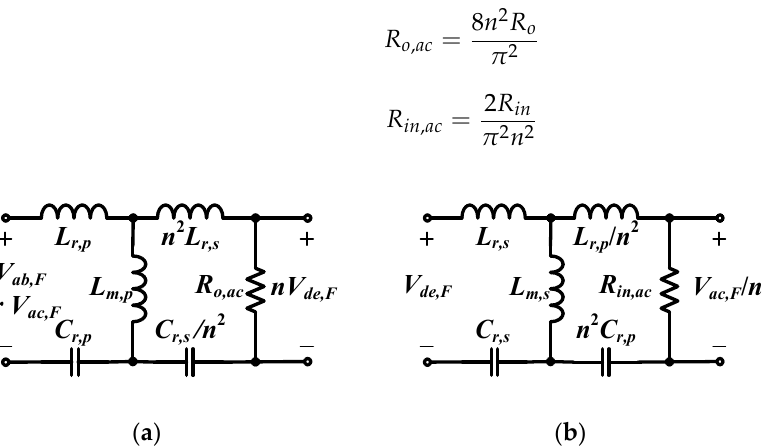
Figure 8. The resonant tank of the proposed converter at fundamental switching frequency: ( a ) forward power operation, ( b ) reverse power operation.